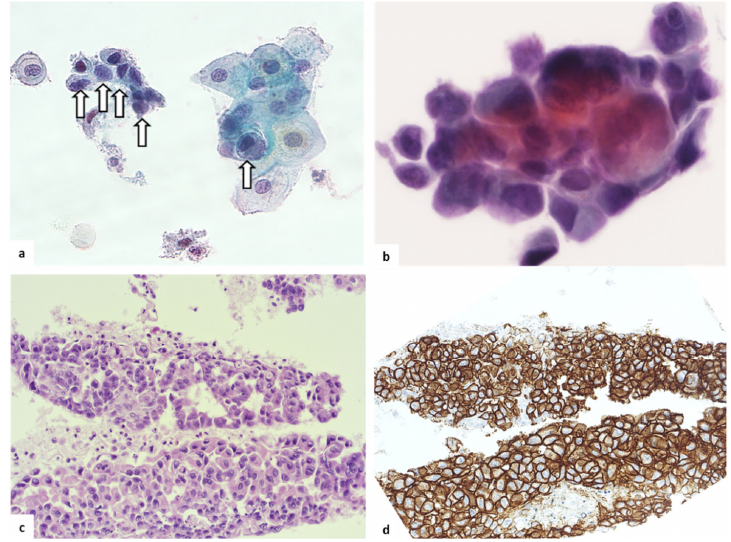
Figure 3. Cervical cytology of EMPD: ( a , b ) liquid ‐ based cytology; ( c , d ) cell block. Note the (arrow) Paget cells as round or columnar cells with an increased N/C ratio (a, 20×), arranged in small clusters (b, 40×) on liquid ‐ based cytology and highlighted on the cell block (c, 20×) by HER2 expression (d, 20×).